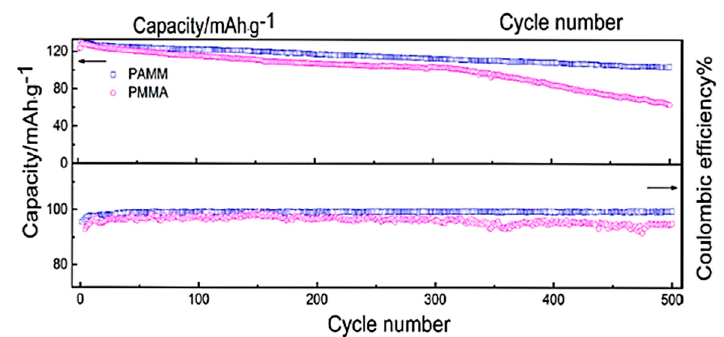
Figure 14. Discharge capacity and Coulombic efficiency of LiNi 0.5 Mn 1.5 O 4 /Li cells using PAMM (poly(acrylic anhydride-2-methyl-acrylic acid-2-oxirane-ethyl ester-methyl methacrylate)) and PMMA (poly(methyl methacrylate-acrylonitrile) at 0.1C [50]